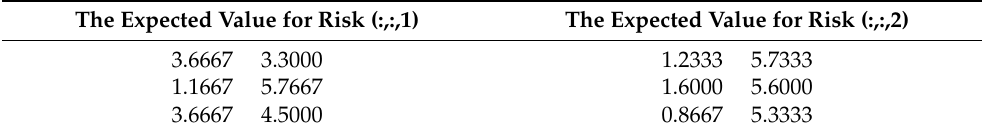
Table 12. Expected value for